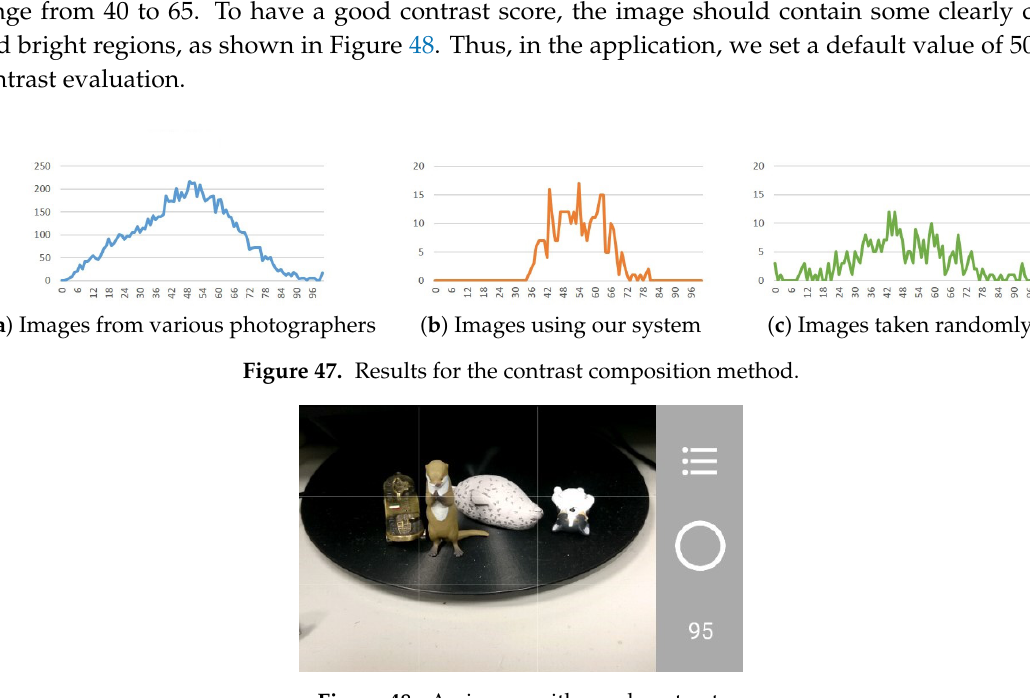
Figure 48. An image with good